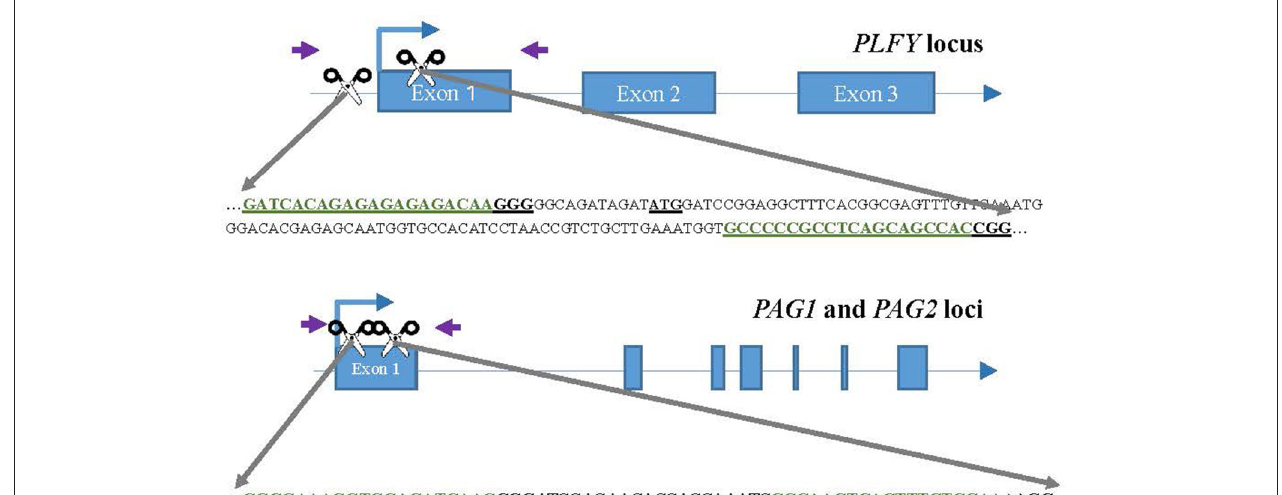
FIGURE 1 | CRISPR/Cas9 sgRNA design and mutation detection in LFY and AG paralogs. Schematic representations of the target sites and the PCR assay for Sanger Sequencing. Exons and introns are represented by blue boxes and blue lines, respectively. The scissors indicate the target sites for each CRISPR/Cas9 nuclease. The purple arrows indicate the approximate location of the primers for sequencing. The target sites are colored in green inside the partial gene sequence. The underlined ATG in LFY indicates the location of the translation start codon.